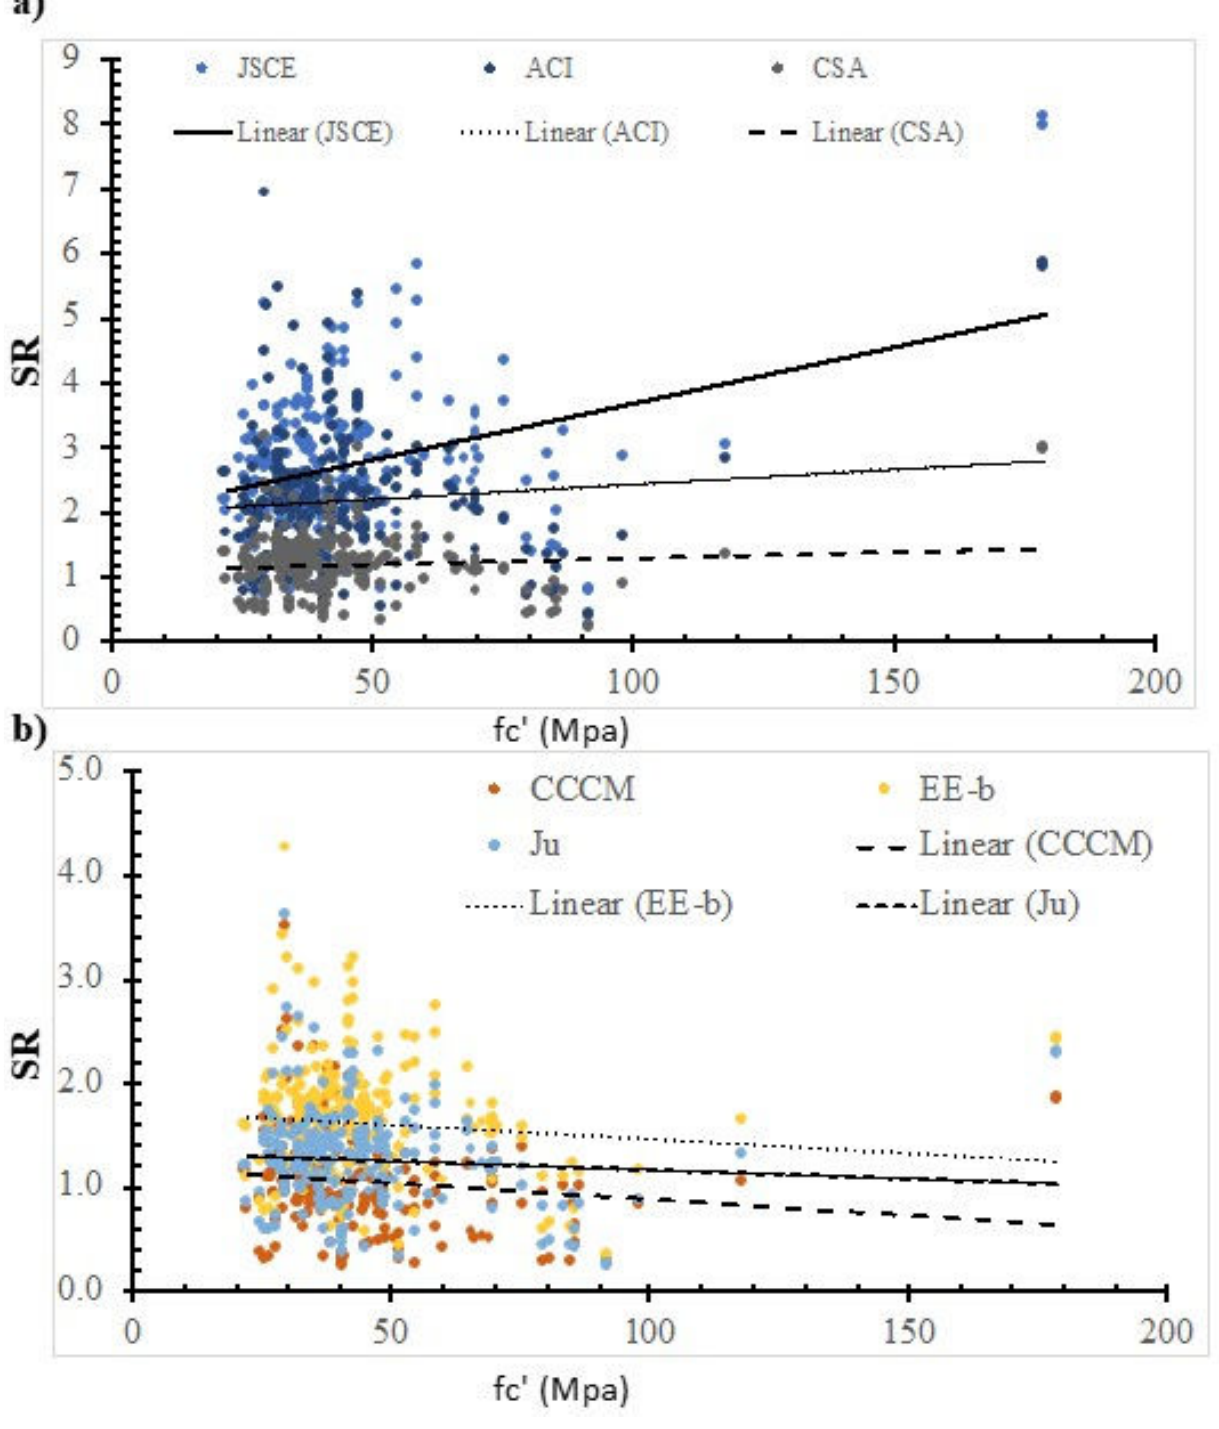
Figure 7. The effect of the concrete compressive strength on the SR value, calculated using selected models. ( a ) Design codes; ( b )